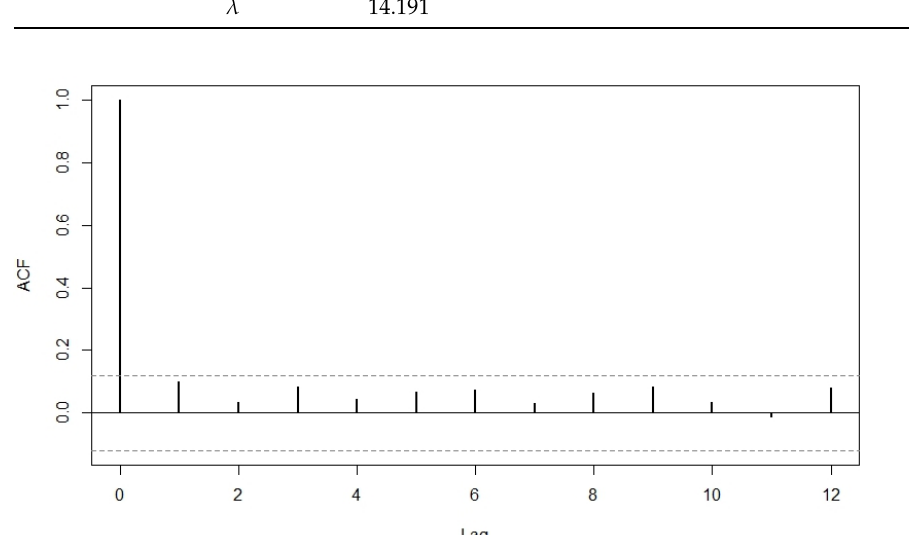
Figure 7. The ACF of the Pearson residuals (13) for the downloads